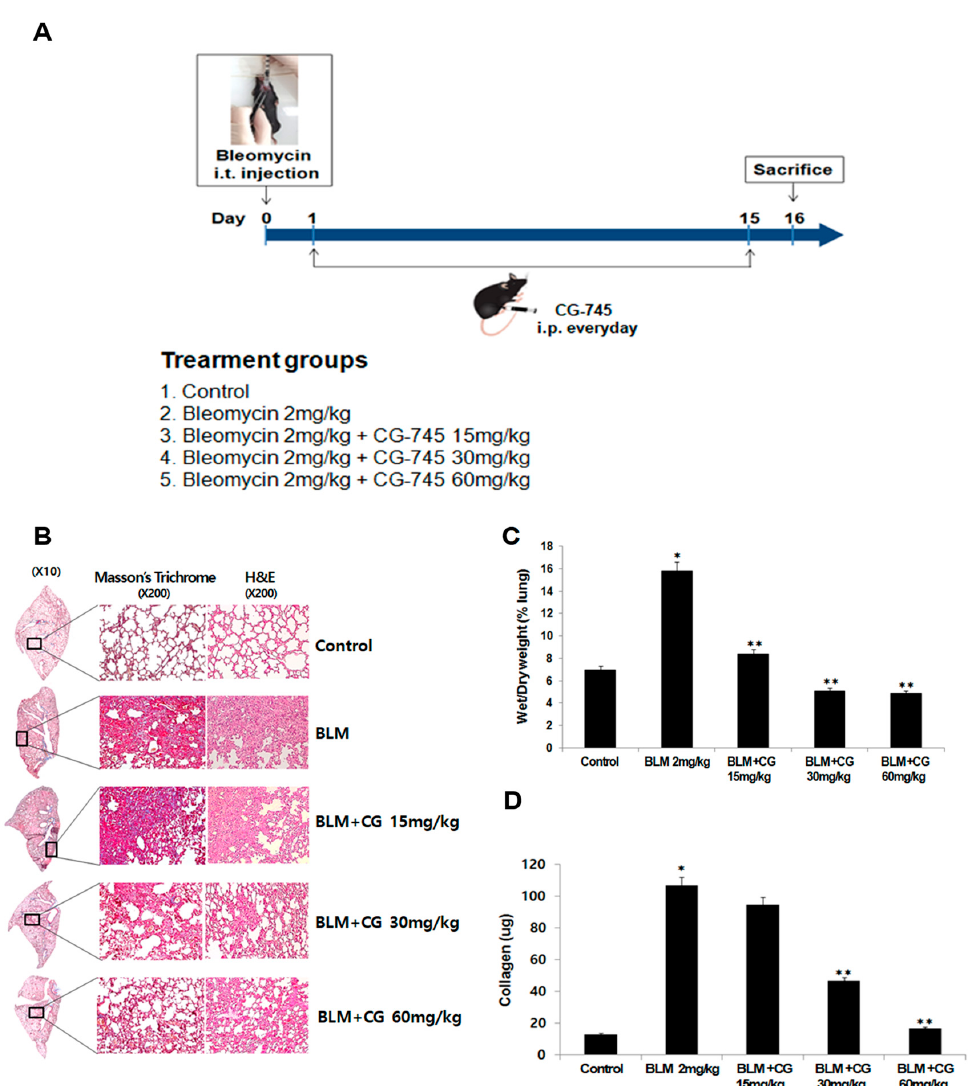
Figure 1. CG-745 ameliorates pulmonary fibrosis induced by bleomycin in mice. ( A ) Mice were instilled with bleomycin (2 mg/kg) intratracheally on day zero, and CG-745 (15 mg/kg, 30 mg/kg or 60 mg/kg) was intraperitoneally administered daily for 14 days. ( B ) Representative histological sections from lung tissues stained with hematoxylin and eosin (H&E) or Masson’s trichrome staining were shown from the control, bleomycin, and bleomycin + CG-745 (15 mg/kg, 30 mg/kg, or 60 mg/kg) group (magnification, ×200). ( C ) The wet/dry measurement was used to detect pulmonary edema. ( D ) Collagen content in the lung tissues was measured by a Sircol assay. Data are presented as mean ± SD, n = 5. * p < 0.01 versus control group. ** p < 0.05 versus bleomycin group.